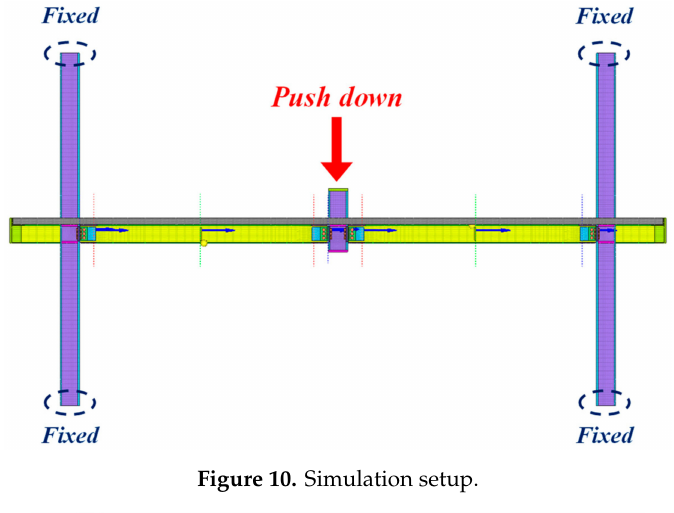
Figure 10. Simulation setup.